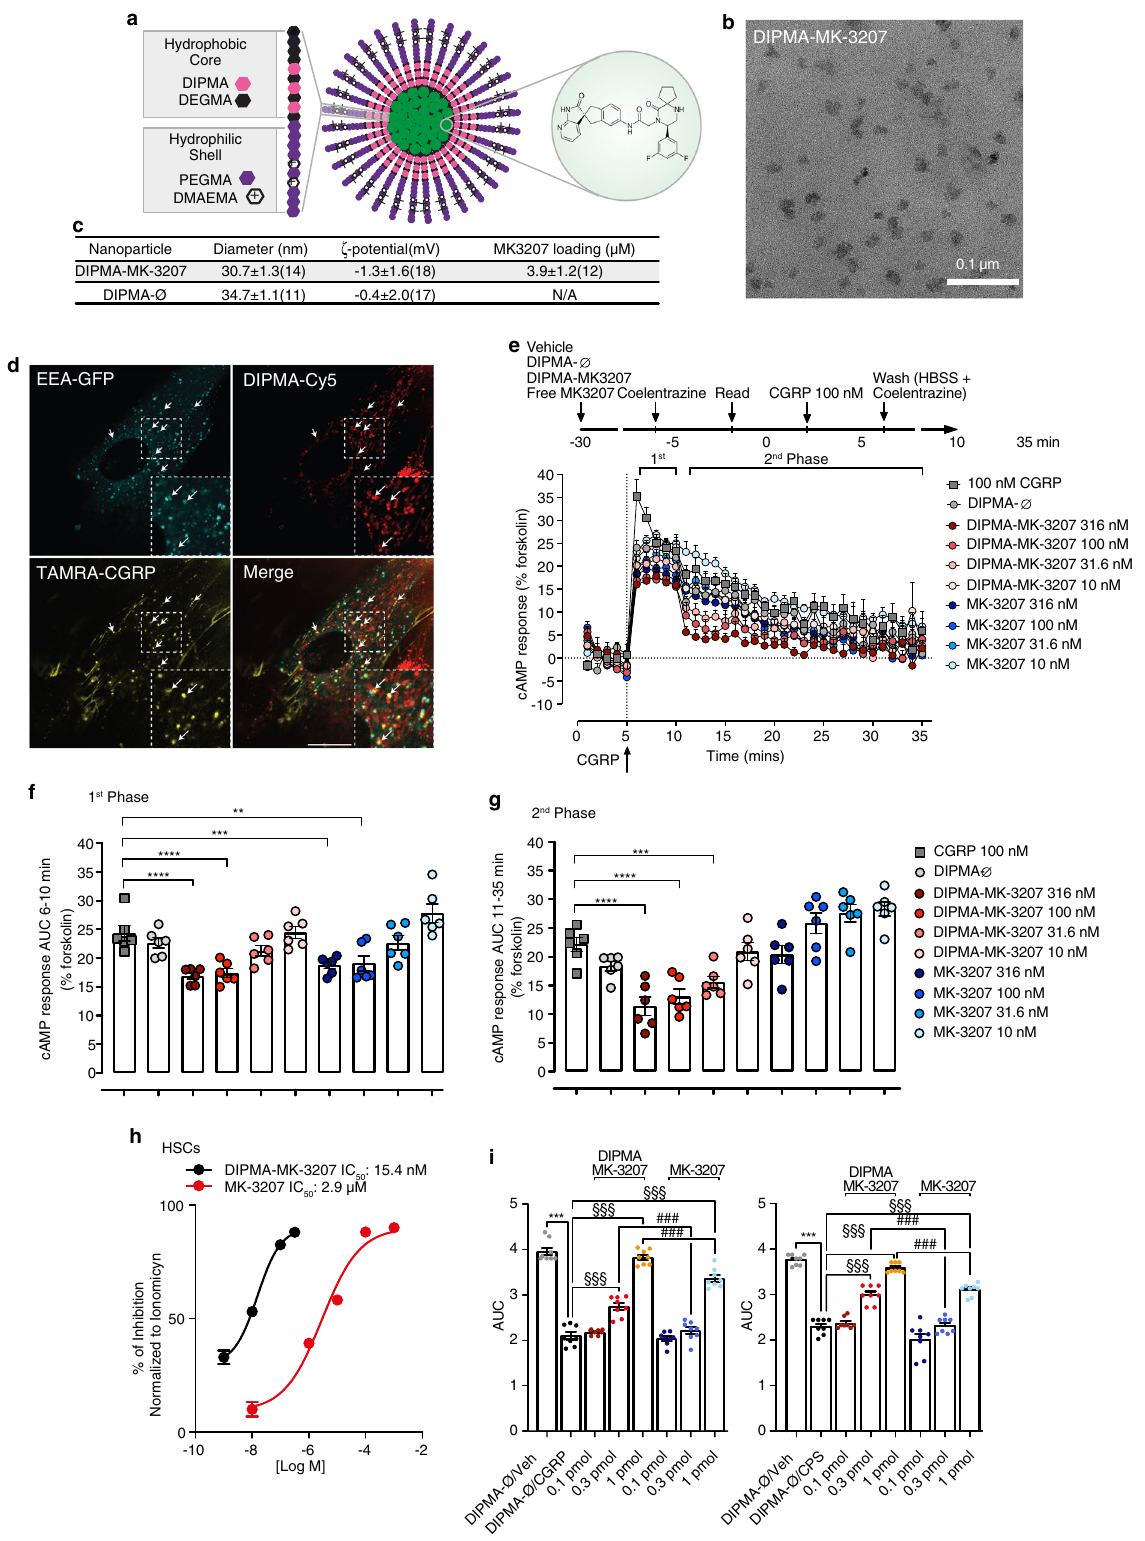
TRPA1. HSCs were preincubated with graded concentrations of DIPMA-MK-3207 or MK-3207 for 20 min to allow the accumula- tion in endosomes, and washed to remove extracellular com- pounds. At 10 min after washing, cells were challenged with CGRP and Ca 2 + response was measured as an index of TRPA1 activity. DIPMA-MK-3207 inhibited CGRP-evoked increase in Ca 2